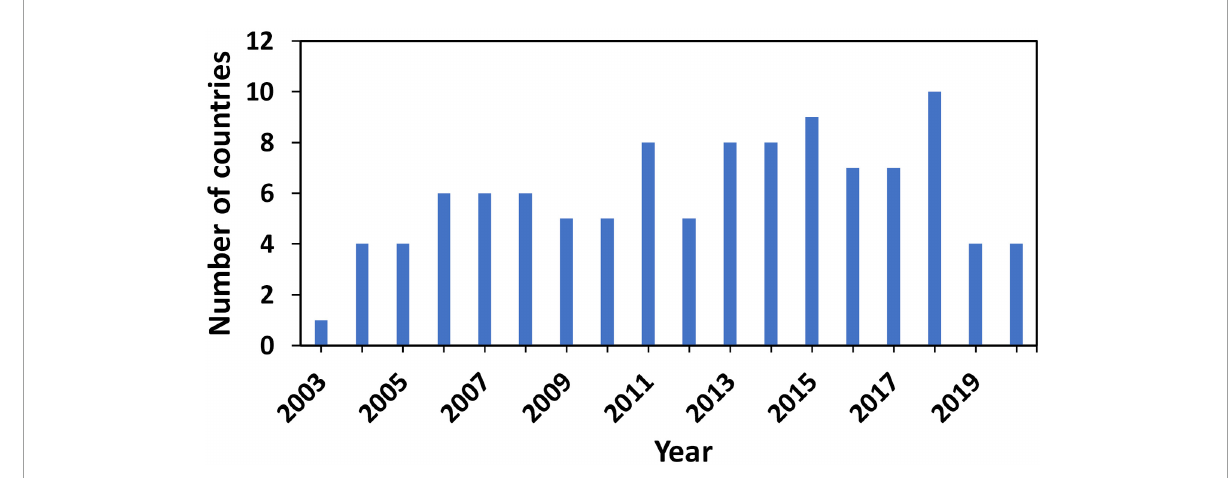
FIGURE3 Number of countries of origin from which wood borers were detected in WPM imported into the US by year from 2003 to 2020.